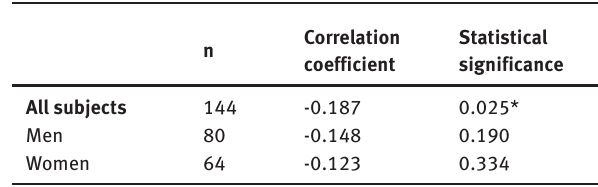
Table 3: The correlation between IL-1 and TNF-α in study subjects